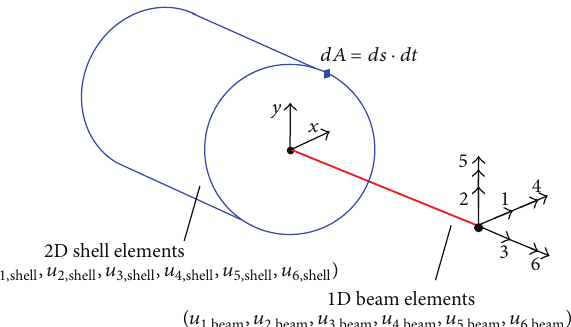
Figure 2: Coupling of 1D element with 2D elements.